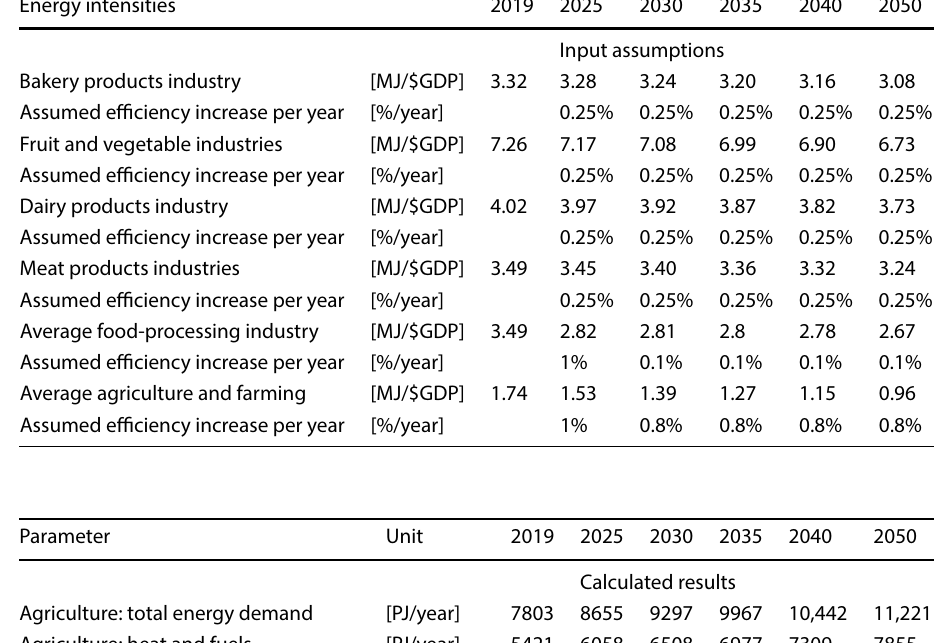
Energy intensities